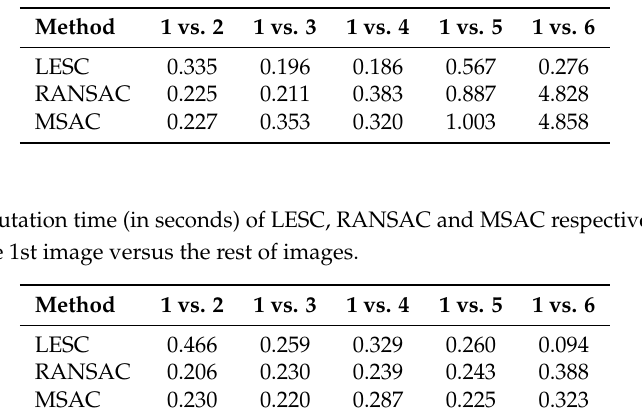
Table 7. The computation time (in seconds) of LESC, RANSAC and MSAC respectively on the UBC sequence using the 1st image versus the rest of images.